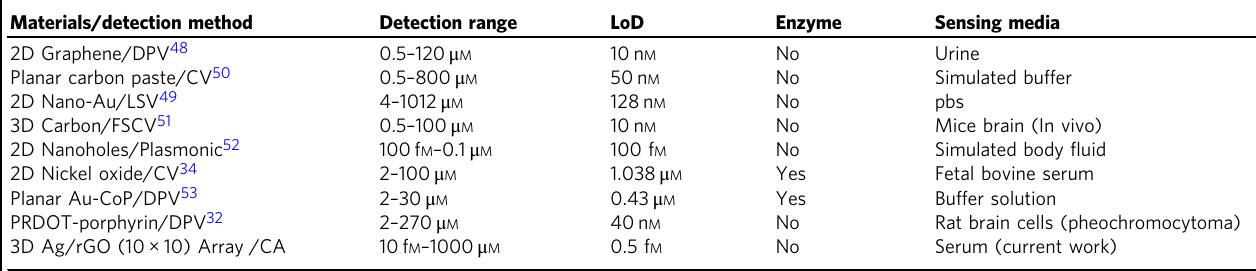
Table 1 Comparison of the detection range and LoD of AJ printed 3D Ag/rGO sensor used in this work with sensors used in literature for dopamine